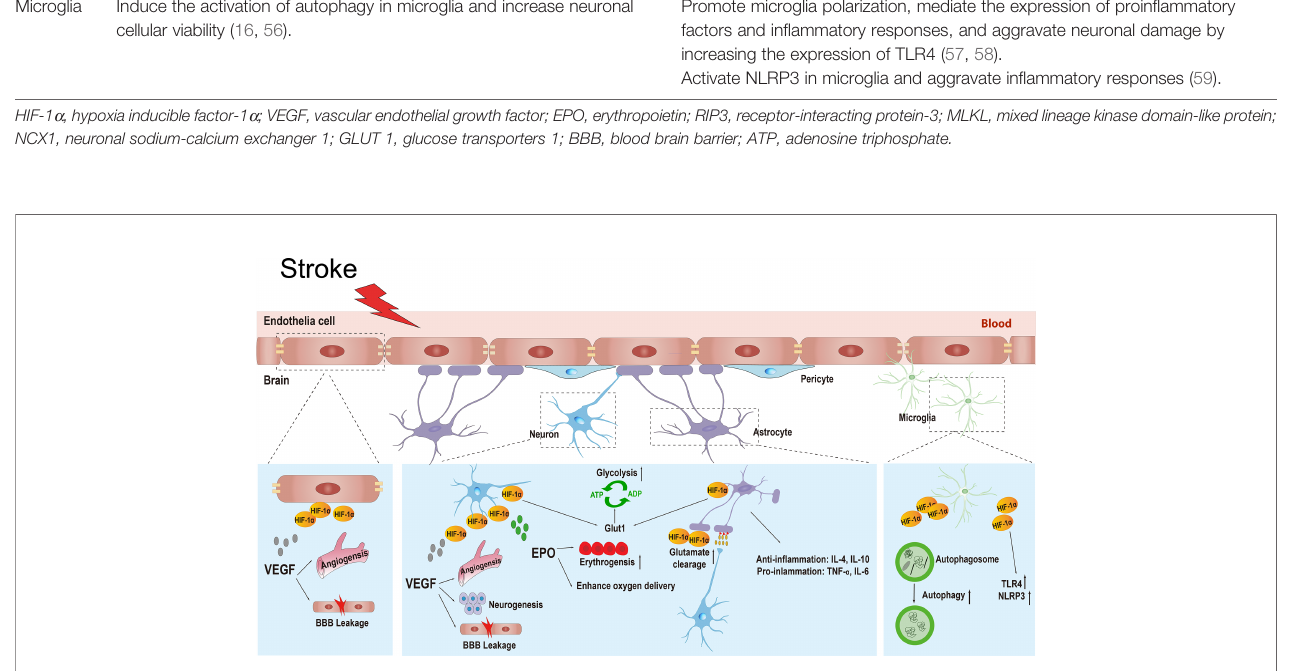
FIGURE 3 | The various physiological functions of HIF-1 a and its target genes in different types of cells in the neurovascular unit including neurons, endothelial cells, astrocytes, and microglial cells during ischemic stroke. HIF-1 a , hypoxia inducible factor-1 a ; VEGF, vascular endothelial growth factor; BBB, blood brain barrier; EPO, erythropoietin; GLUT1, glucose transporter 1; ATP, adenosine-triphosphate; ADP, adenosine-diphosphate; IL-4, interleukin-4; IL-10, interleikin-10; TNF- a , tumor necrosis factor- a ; IL-6, interleukin-6; TLR4, toll-like receptor 4; NLRP3, recombinant NLR Family, pyrin domain containing protein